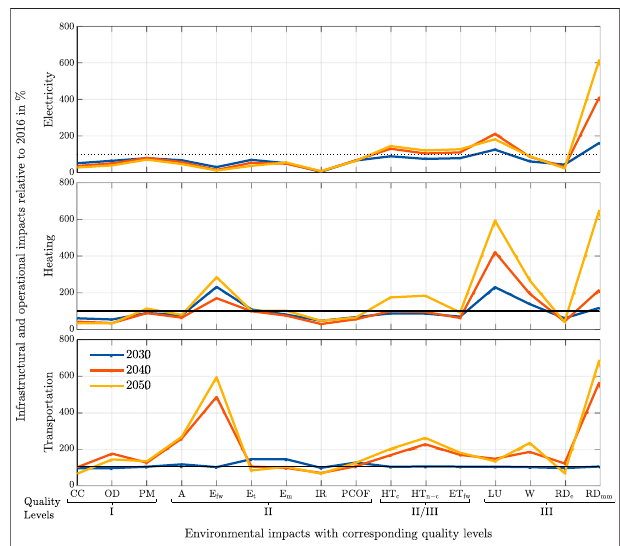
FIGURE 7 | Operational and infrastructural environmental impacts for 1 MWh power electricity, MWh heat heating, and for 1 vkm of private transportation. The environmental impacts of 2016 are used as reference (dotted black line: 2016 (cid:2) 100%). For abbreviations and quality levels, see Table1 .Electricityusedinheatingandtransportationsectorisaccounted for in these sectors.